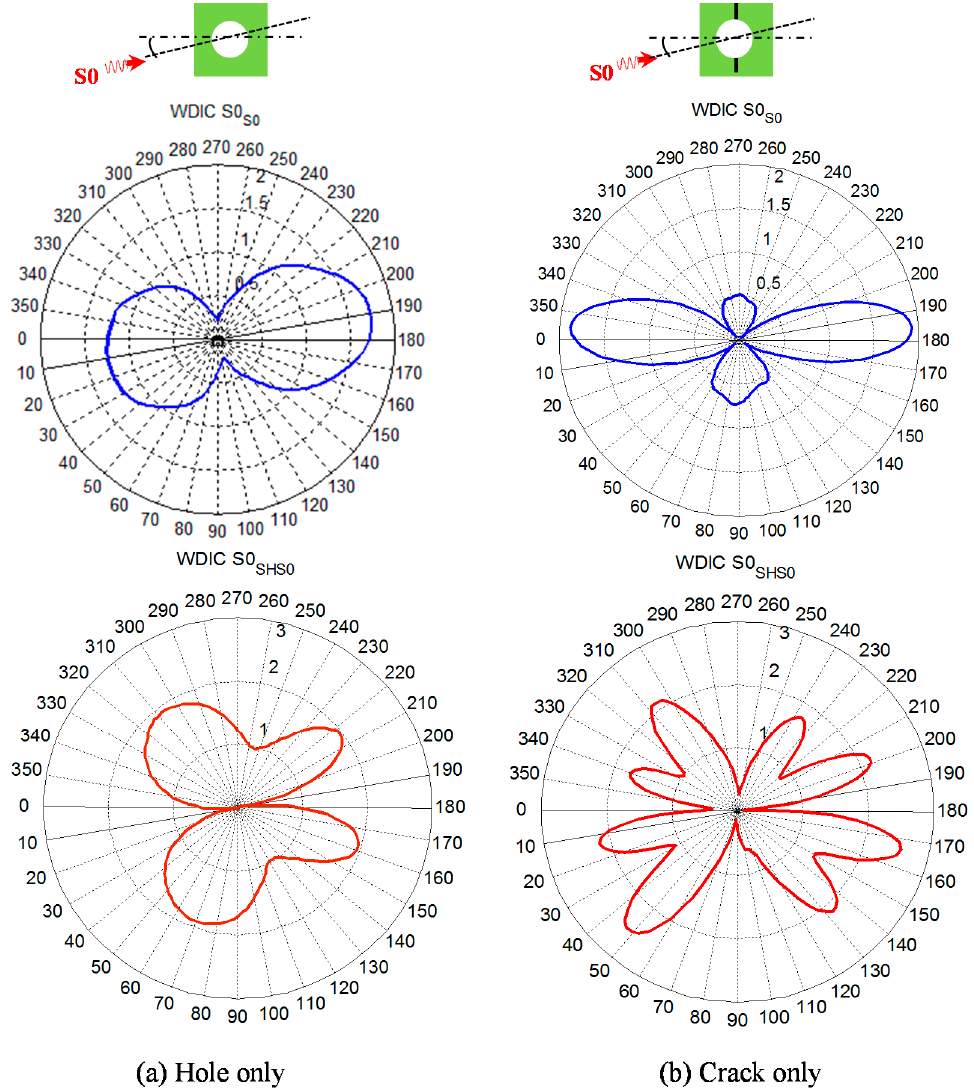
Figure 6. Subtracted WDIC profiles of scattered Lamb and SH waves to account the damage effect only: ( a ) Hole only; ( b ) Crack only.